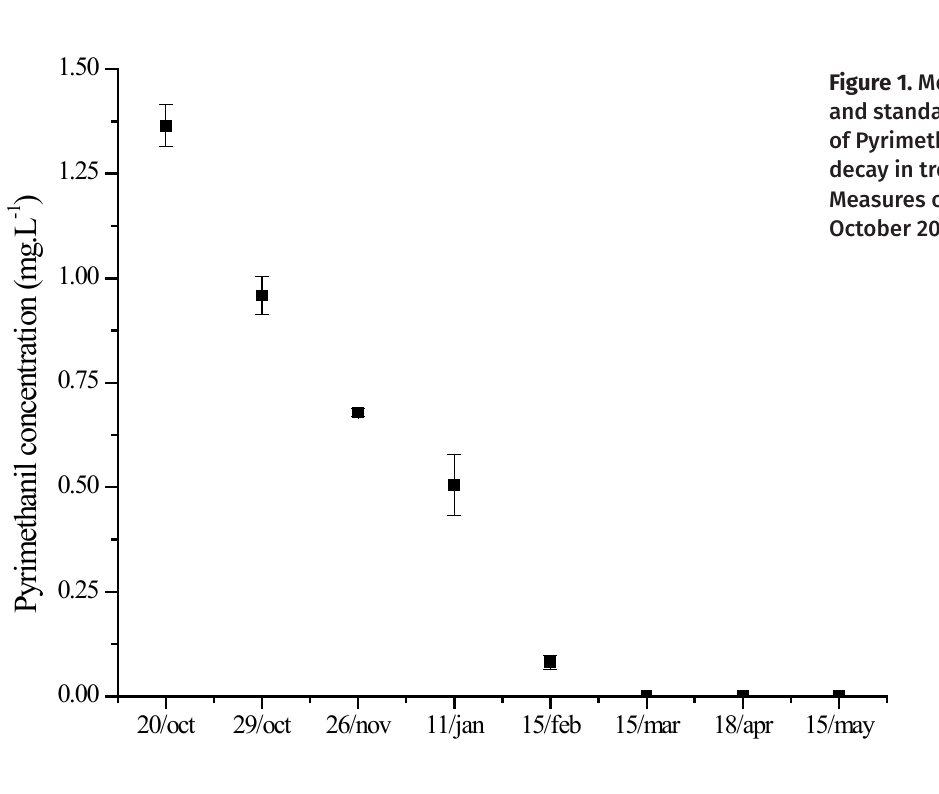
Figure 1. Mean concentrations and standard deviation of Pyrimethanil fungicide decay in treated mesocosms. Measures obtained from October 2012 to May